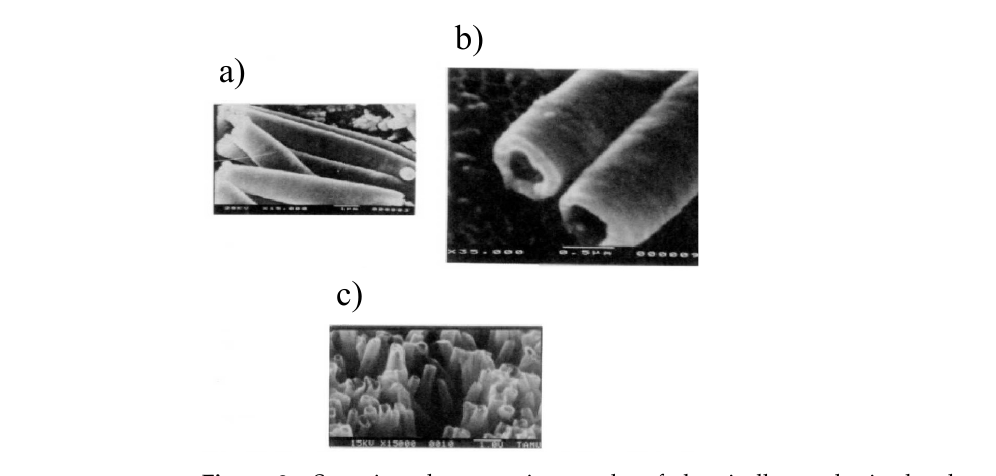
Figure 3. Scanning electron micrographs of chemically synthesized polypyrrole microtubules ( a , b ) and electrochemically synthesized poly(N ‐ methylpyrrole) microtubules ( c ) [27], Copyright 2011. Reproduced with permission from the publisher: Springer.